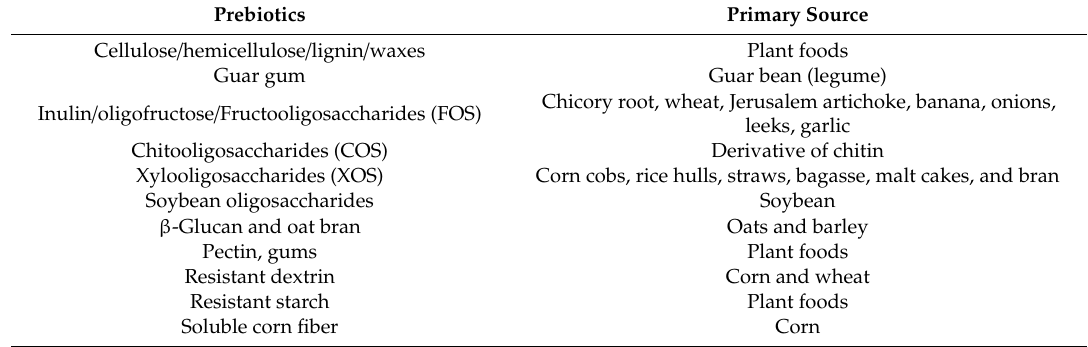
Table 1. Individual prebiotics and their sources fruit or vegetable source. Adapted from Shigwedha et al. [100]. Prebiotics Primary Source Cellulose / hemicellulose / lignin / waxes Plant foods Guar gum Guar bean (legume) Chicory root, wheat, Jerusalem artichoke, banana, onions, Inulin / oligofructose / Fructooligosaccharides (FOS) leeks,